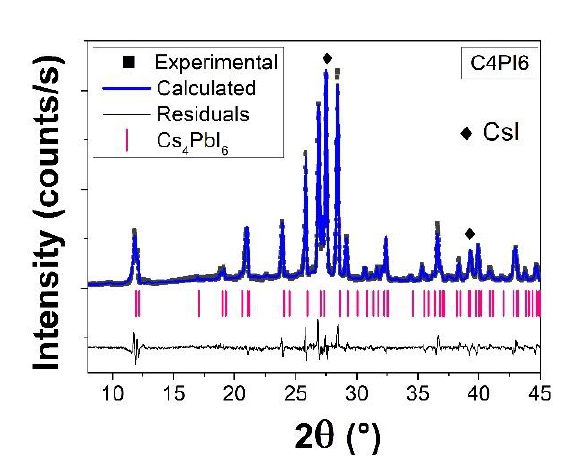
Figure 3. Rietveld refinement of C4PI6 sample. (cid:4) refers to Experimental pattern, color line is the pattern calculated by Rietveld refinement, in Black line the residuals between experimental and calculated pattern, the vertical bar indicates the theoretical peaks characteristic of Cs 4 PbI 6 . Table 1. Results of Rietveld refinement on CPI3 samples at room temperature.